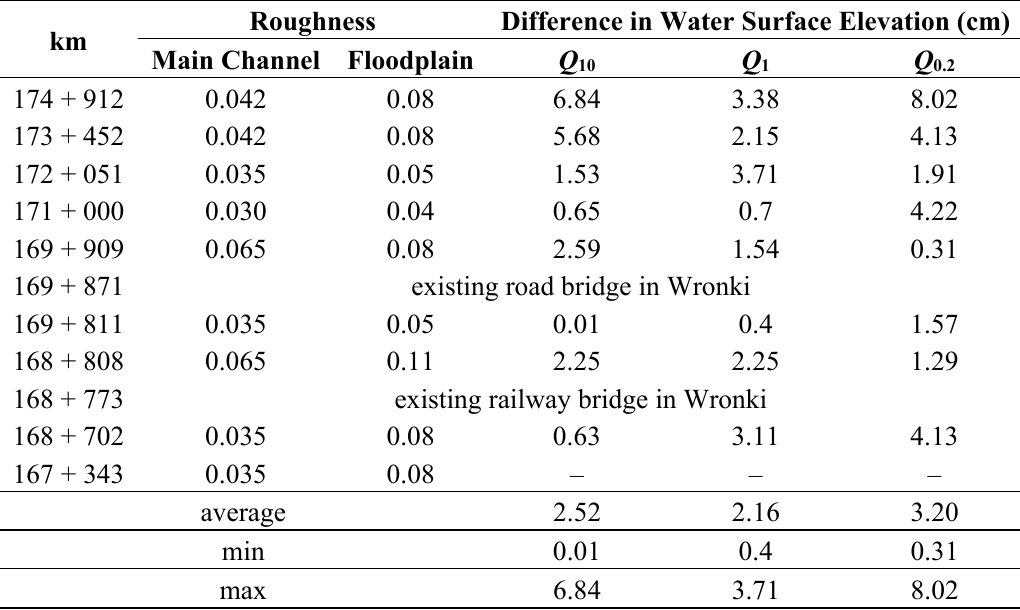
Table 2. Selected results of model